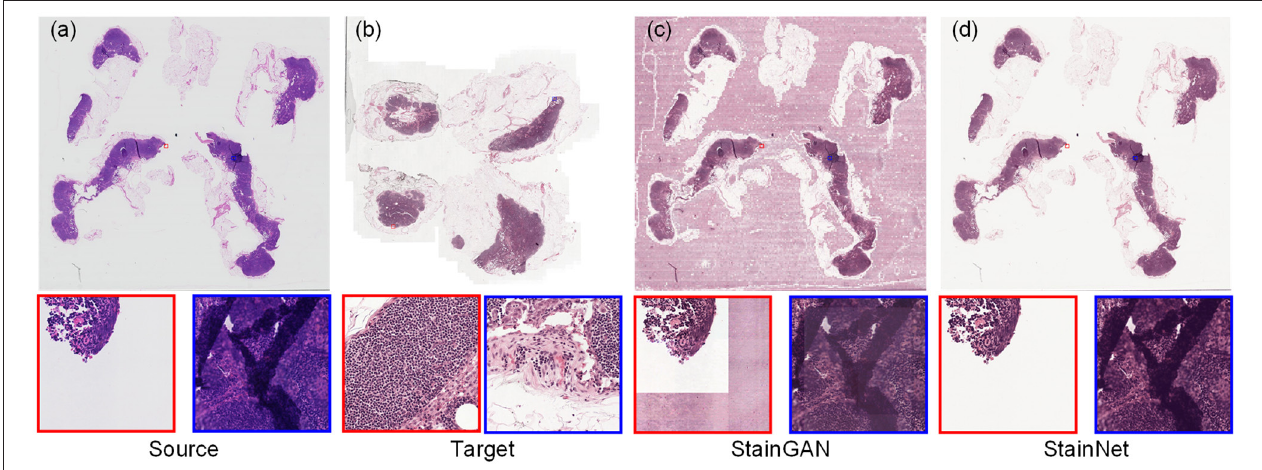
FIGURE 7 | The whole slide image normalization result on the Camelyon16 dataset. The source slide (a) , the target slide (b) , the normalized slide by StainGAN (c) , and the normalized slide by StainNet (d) are listed.